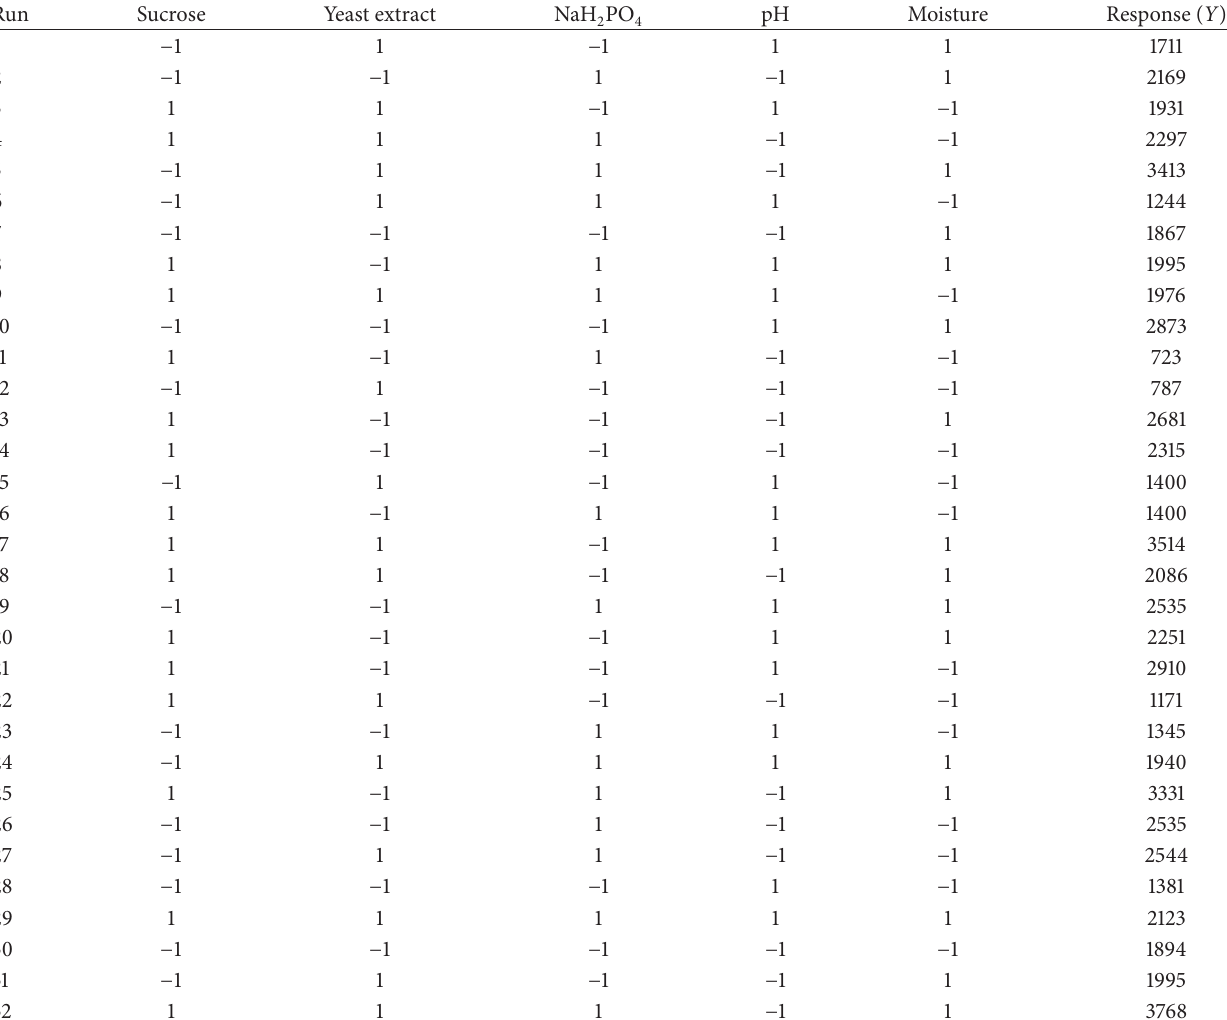
Table 1: Experimental design and results of the 2 5 fractorial design.